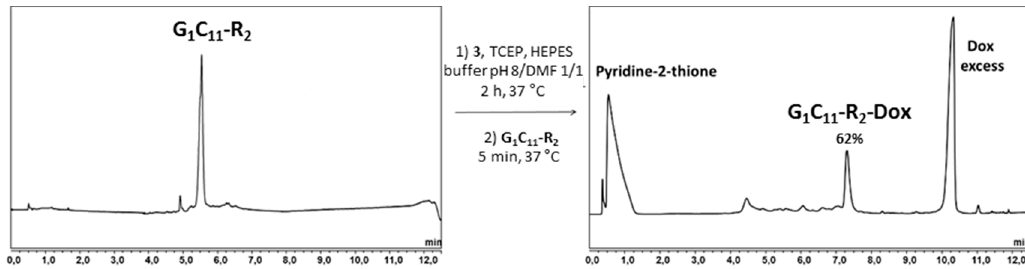
Figure 2. RP-HPLC profiles of solution phase conjugation of RNA G 1 C 11 -R 2 (left) with Dox-SS-Py derivative 3 to give bi-Dox-RNA conjugate G 1 C 11 -R 2 -Dox (right).